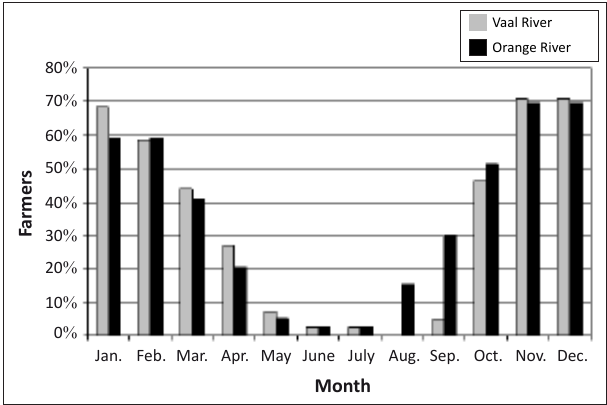
FIGURE 3: Percentage of farmers who indicated highest blackfly annoyance for a specific month along the Orange and Vaal